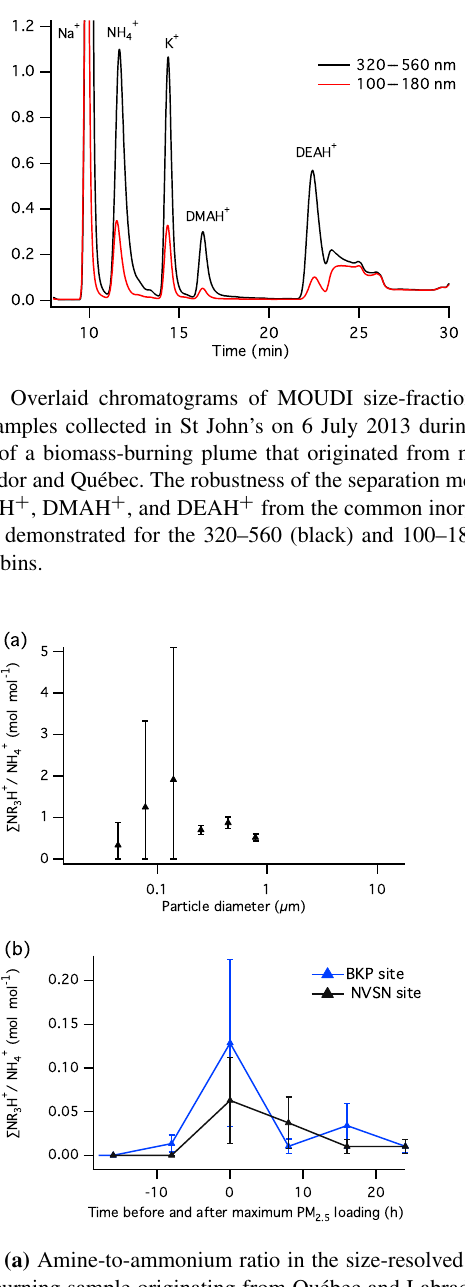
pled at both sites were calculated to be 20 h old, or